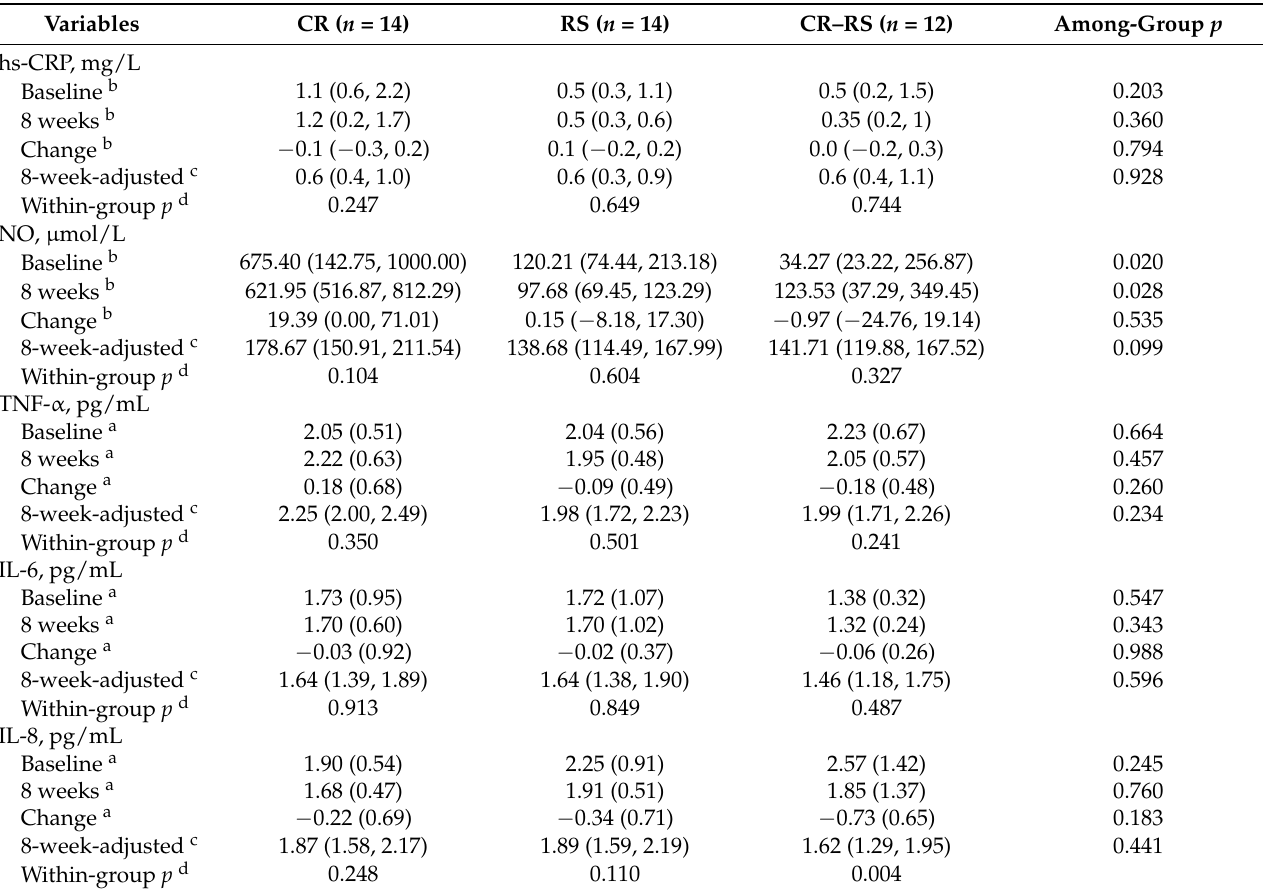
Table 4. Intervention effects on inflammatory